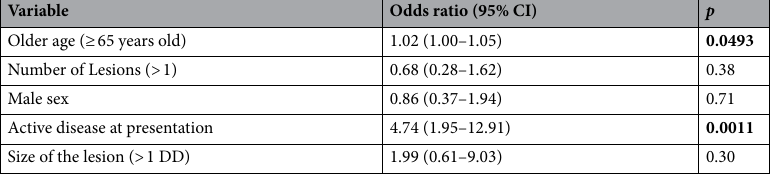
Table 6. Multivariate binary logistic regression of variables associated with reactivation of ocular toxoplasmosis (n = 292 eyes). DD = disc-diameter; CI = confidence interval.